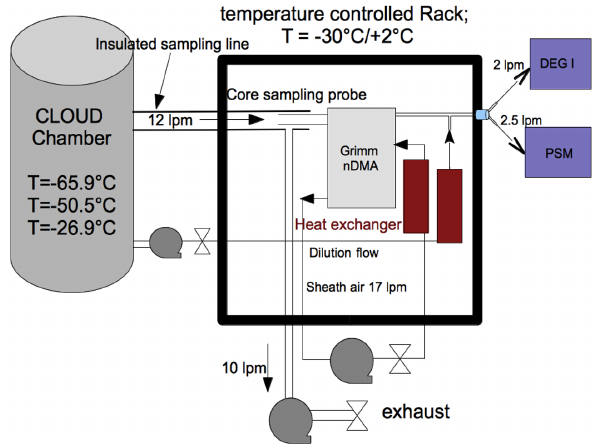
Figure 1. Sketch of the calibration setup. The calibration unit was in a temperature-controlled rack, while the CPCs were at room tem- perature. The temperature inside the rack was 245.15K for the mea- surements at lower temperatures, whereas the rack temperature was 275.15K for the measurements at 246.25K in the chamber. To min- imize diffusion losses, a core sampling probe was used from the chamber to the calibration system. The CLOUD chamber was used to produce naturally charged particles. A nano-DMA was used to size select the particles and as reference a PSM, with a significantly lower cut-off (1.1nm) than the calibrated CPC. The sheath air of the DMA and the dilution flow after the DMA went through a heat ex- changer, consisting of copper tubing to ensure the same temperature for all